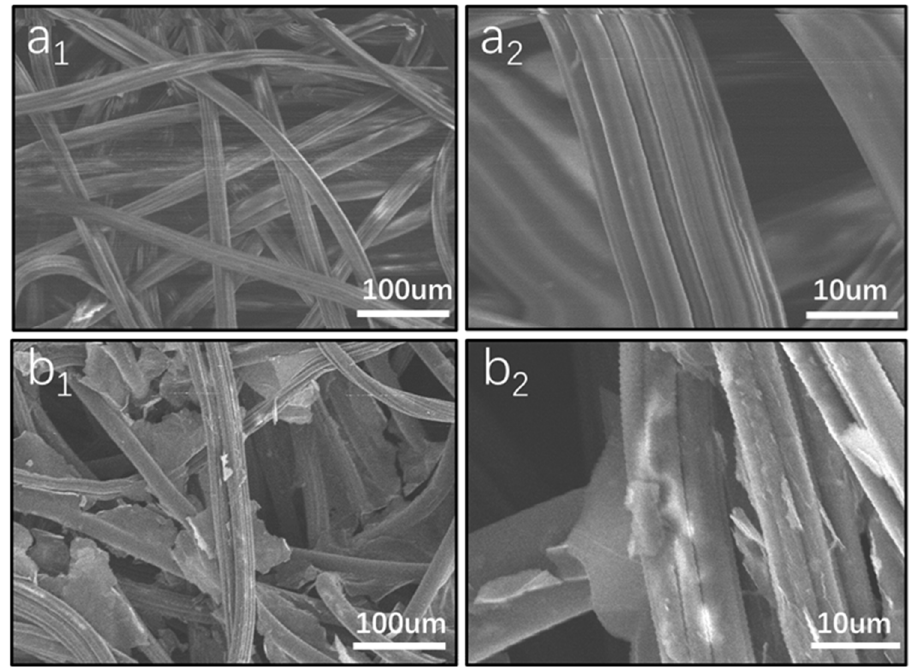
Figure 8. SEM images of the graphene oxide-loaded nonwoven fabric show in different amplified times: ( a1 , a2 ) pristine non-woven fabric of different resolutions; ( b1 , b2 ) modified non-woven fabric with a 0.5% graphene oxide of different resolutions.